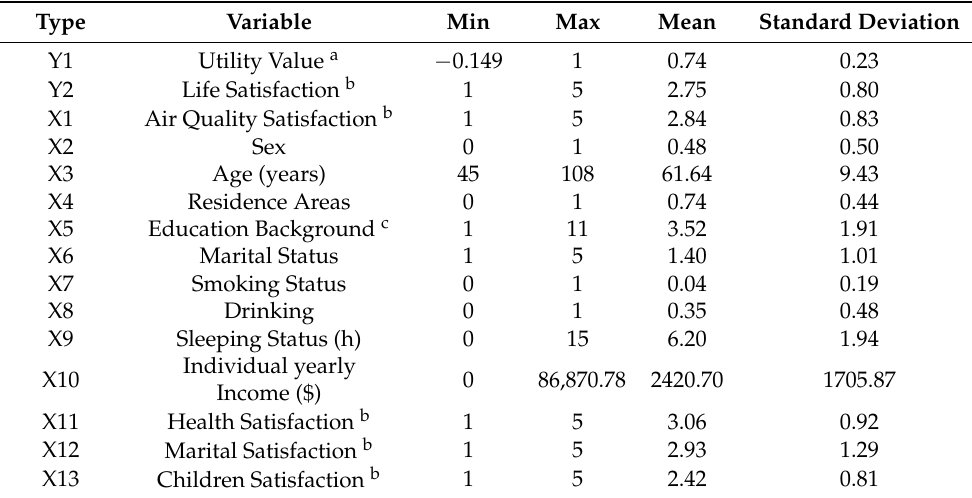
Table 1. Descriptive statistics